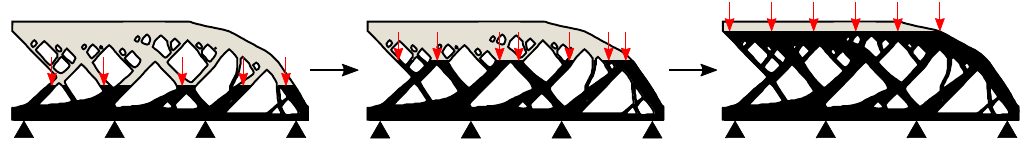
Figure 4. Three intermediate build instances with heat flux and sink boundary conditions represented by vertical arrows and triangles, respectively. The horizontal arrows indicate that thermal history of all previous heating/cooling steps are passed to the next simulation step.